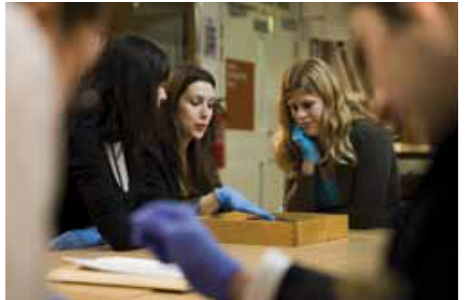
Fig. 1: Teaching in the newly refurbished Petrie